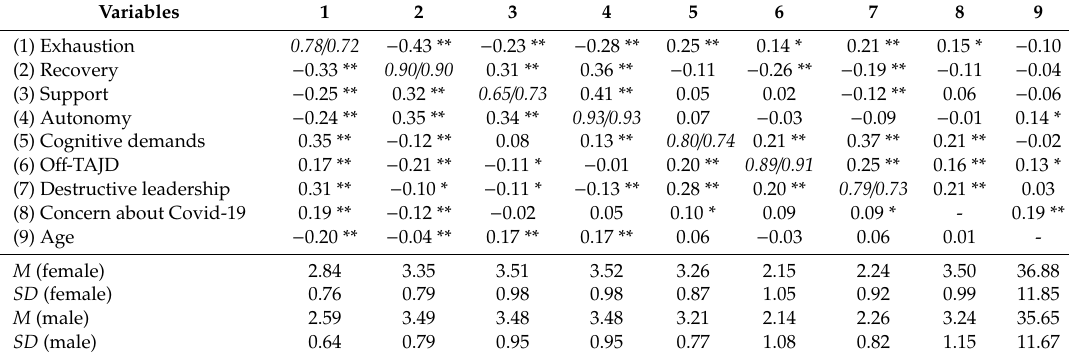
Table 1. Means, standard deviations, Cronbach’s alphas, and correlations for women (n = 437) and men (n = 279).